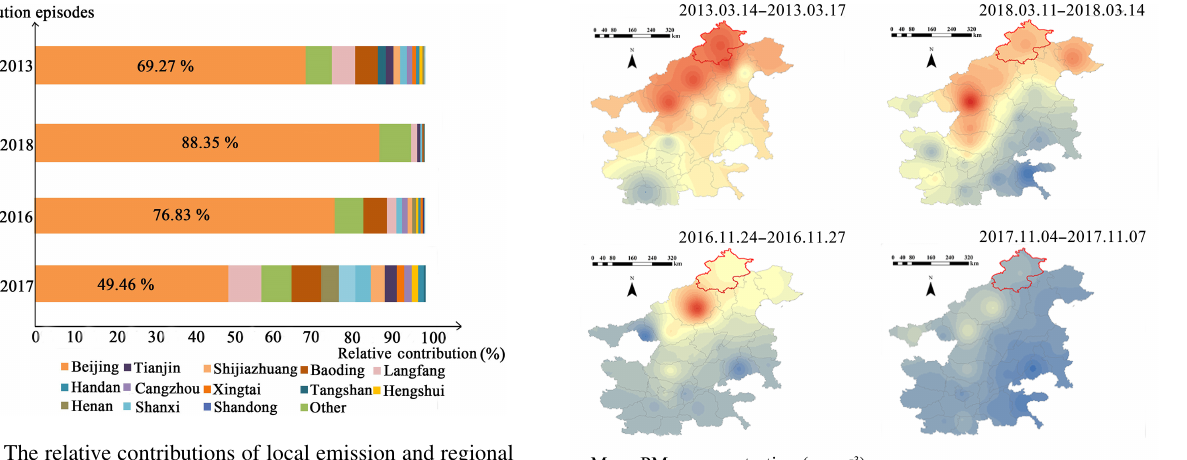
Figure 5. The relative contributions of local emission and regional transport to PM 2 . 5 concentrations in Beijing during the four pollu- tion episodes.